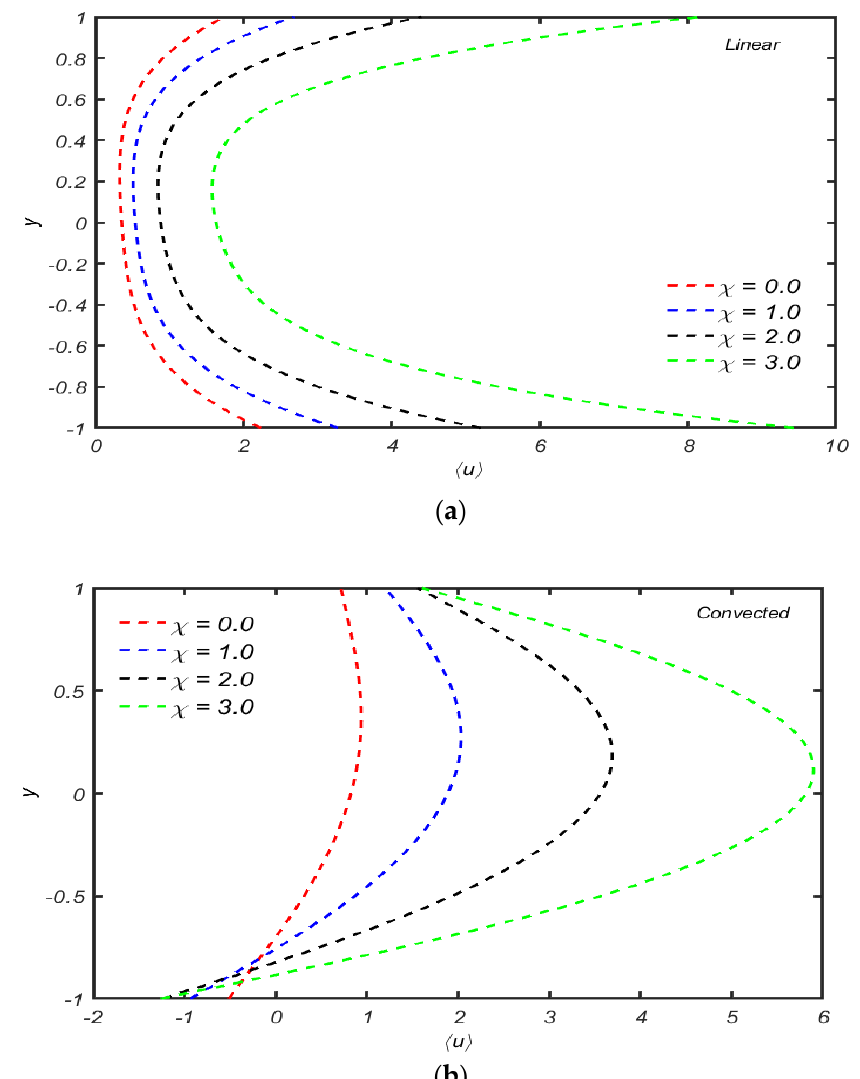
Figure 7. ( a ) Variation of mean axial velocity distribution for several values of χ with R = 10, α = 0.4, λ 1 = 0.5. ( b ) Variation of mean axial velocity distribution for several values of χ when other parameters are R = 1, α = 0.4, λ 1 =